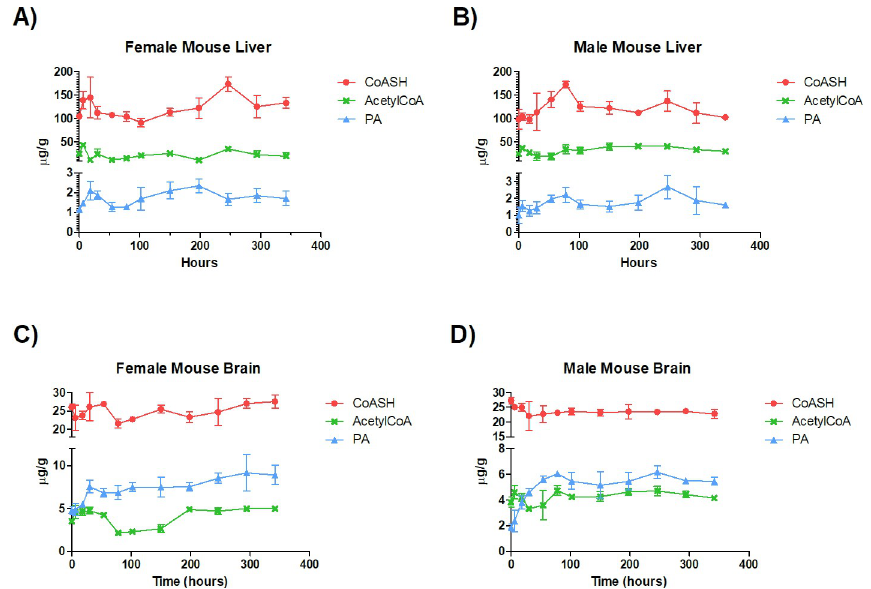
Fig 2. Level of unlabelled pantothenic acid (PA), free CoA (CoASH) and acetylCoA in A) female and B) male mouse liver and C) female and D) male brain after administration of a single oral dose of [ 13 C 3 - 15 N]-PA. C57BL/6N mice were kept for 3 days under a PA-free diet and then orally dosed with 25 mg/kg of [ 13 C 3 - 15 N]-PA. Liver and brain samples were harvested over a collection period of 0–342 h and unlabelled PA, CoASH and acetylCoA level were measured by LC-MS.